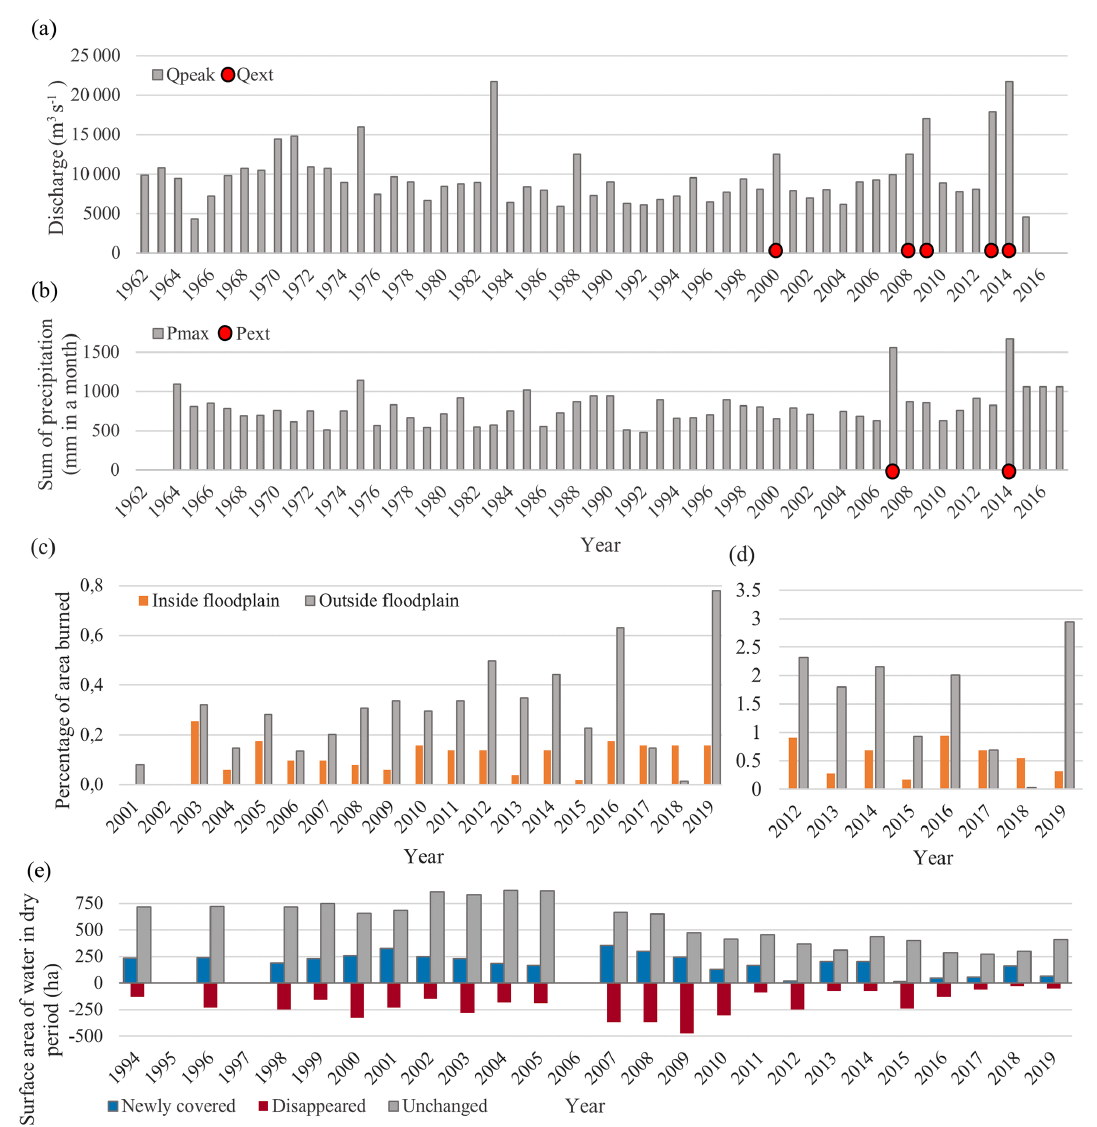
Figure 5. Environmental drivers. (a) Yearly maximum peak discharge ( Q peak ) and identified extremes ( Q ext ) are shown for the discharge dataset. (b) For each year the month with the most precipitation ( P max ) is shown, along with the identified extreme years ( P ext ) . (c, d) Surface area affected by fires in and outside the floodplain as detected from the MODIS (c) and VIIRS (d) datasets, respectively. (e) Change in surface area (hectares) covered by channels for each year compared to previous year, where newly covered means area covered by new channels, disappeared means area abandoned by channels, and unchanged means area covered by channels in the current year and previous